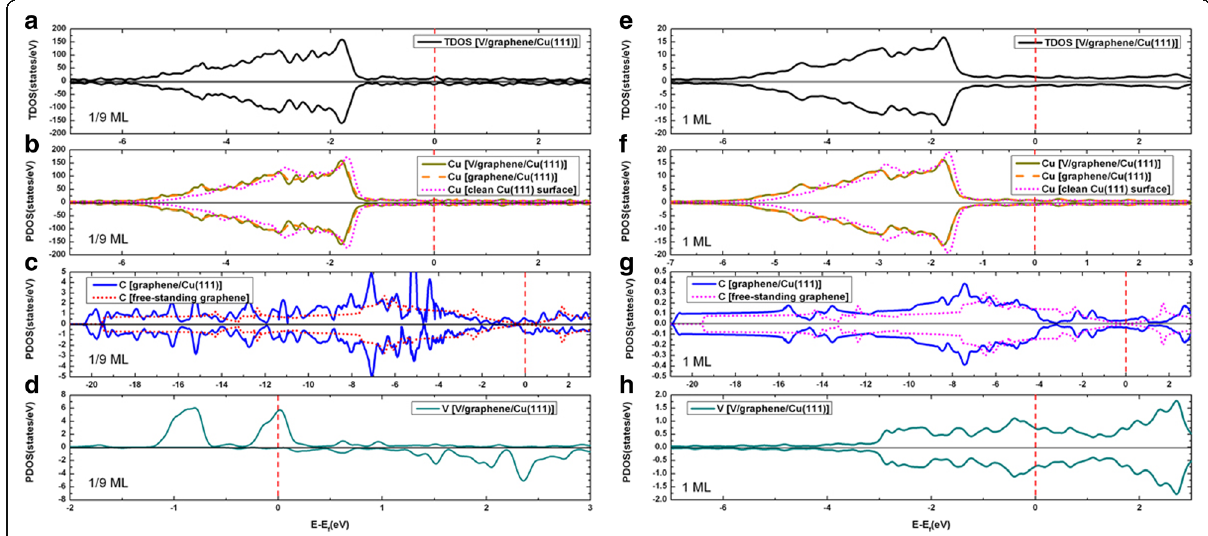
Fig. 9 a TDOS of V adsorption on graphene-covered Cu(111) surface at 1/9 ML coverage; PDOS for b Cu atoms, c C atoms, and d V adatoms at 1/9 ML. Likewise, e TDOS of V adsorption on Gra/Cu(111) surface at 1 ML coverage; PDOS for f Cu atoms, g C atoms, and h V adatoms at 1 ML. For comparison, PDOS of Cu atoms of a clean Cu(111) and graphene/Cu(111) are implanted in b and f , while PDOS of C atoms of a free-standing graphene are also implanted in c and